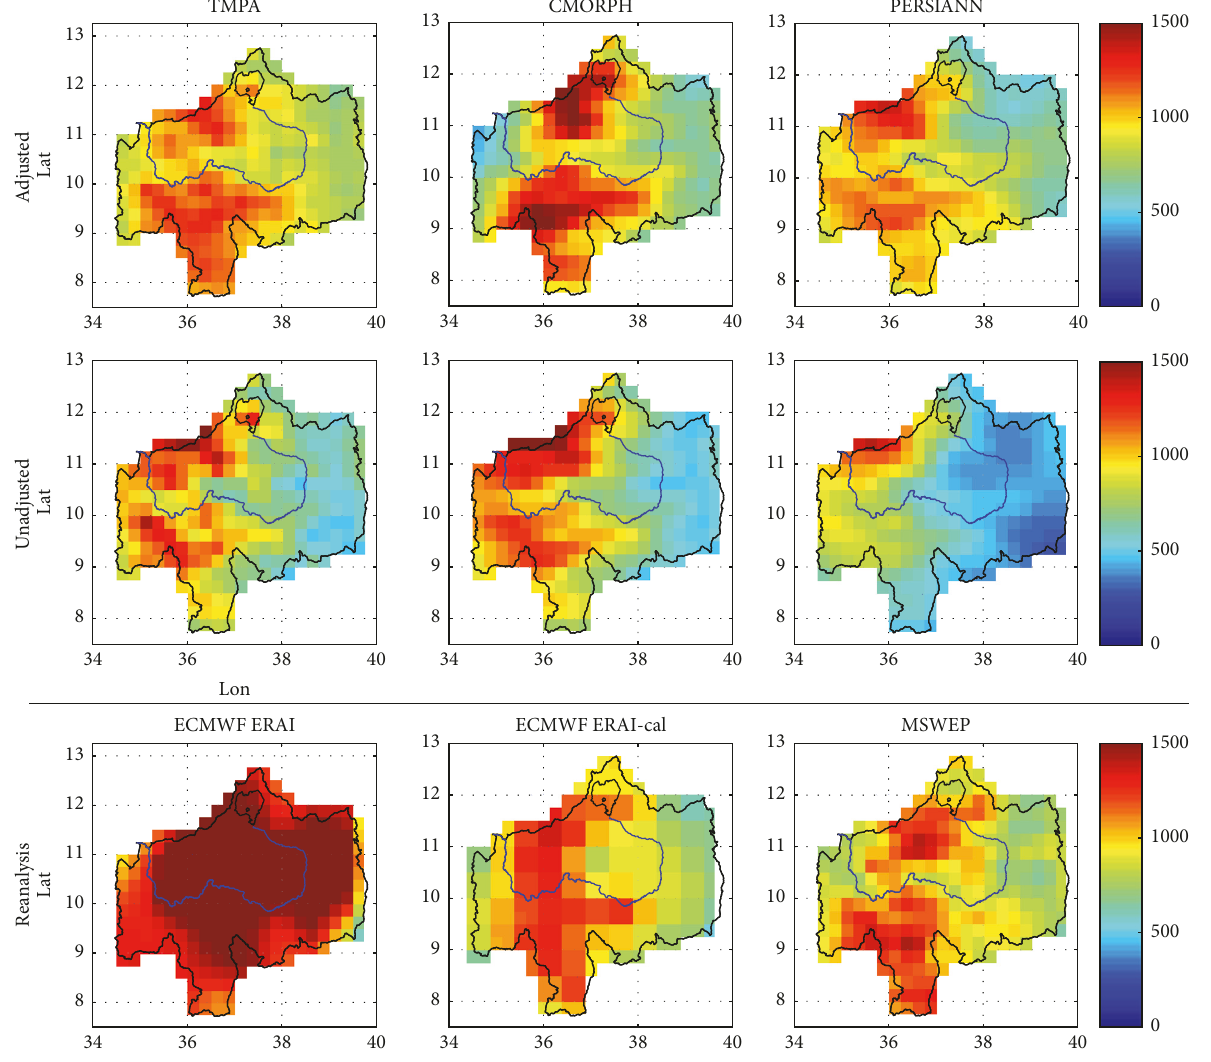
Figure 2: Spatial pattern of mean season rainfall (mm) for the period June to